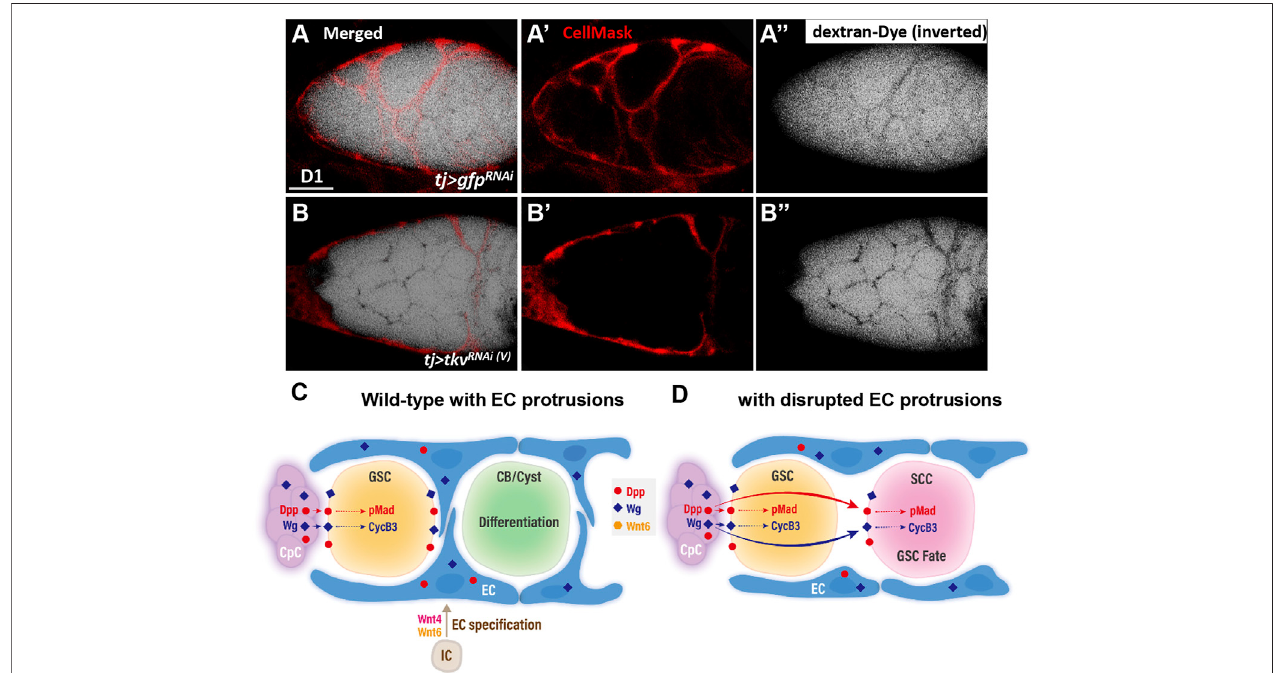
FIGURE7| Apermeability assayforthe ovaryassayrevealstherole ofEC protrusionswarpping germ cellsand acting asaphysical permeability barrier. (Aand B) One-day-oldlive tj > gfp RNAi (A) and tj > tkv RNAi(V) germaria (B) withCellMask(red,ECcellmembrane)anddextran-488(dextrasignalsareinvertedforbettervisualization, a fl uorescencedye).AandBaremergedimages; (A ’ andB ’ ) showonlyCellMaskchannerand (A ” andB ” ) showonlydextran-488channel.Scalebar,10 μ m. (CandD) Model of canonical Wnt signaling in EC speci fi cation and promotion of EC protrusions to set Dpp and Wg territories and maintain germline homeostasis. (C) In the developing wildtype ovary, canonical Wnt signaling in intermingled cells (ICs) is at least in part activated by Wnt4 and Wnt6. This signaling is critical for escort cell (EC) formationandmaintainsECprotrusions.TheECprotrusionsservetocompartmentalizeGSCprogenyandshieldthegermcellsfromDppandWgproducedbycapcells (CpC),allowingtheGSCprogenytoproperly differentiate. InGSCs,DppsignalingleadstoMad phosphorylation (pMad),and upregulation ofCycB3probably occursvia transcriptional activation by Wg signaling. These events are critical to maintain GSC fate. (D) In the germarium with blunted EC protrusions, Dpp and Wg also signal to GSC progeny and disrupt their differentiation. CB, cytoblast; cyst, germ cell